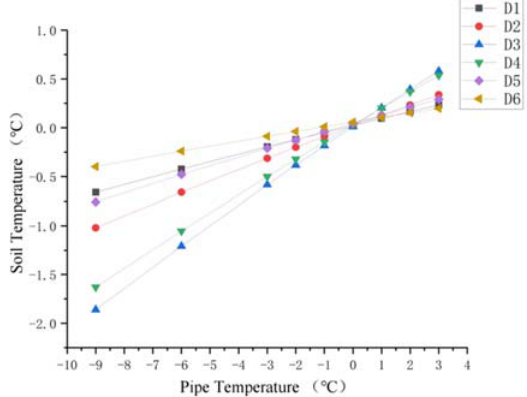
Figure 17. Diagram of soil temperature trend at point D1–D6.